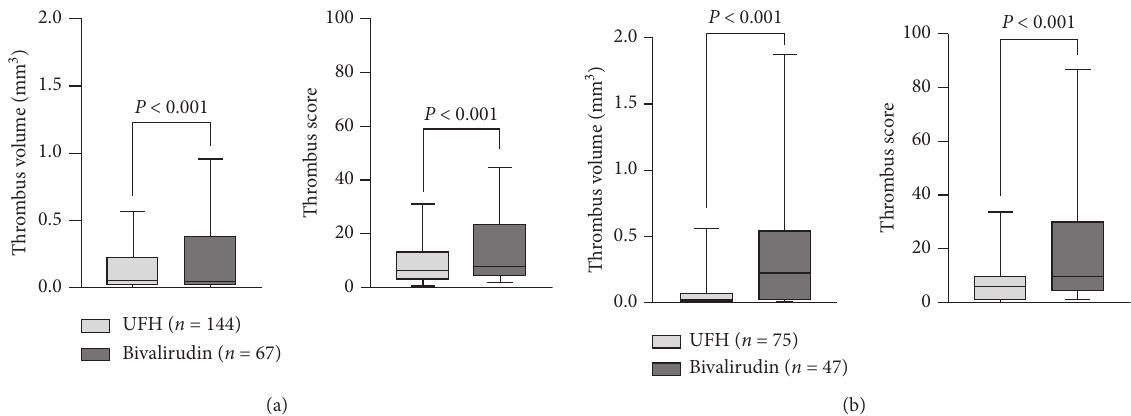
Figure 3: Box and whiskers of thrombus volume and score between the bivalirudin group and the UFH group before and after propensity score matching. The whisker bars represent the 10–90 percentile of total thrombus in each group. (a) Before propensity score matching. (b) After propensity score